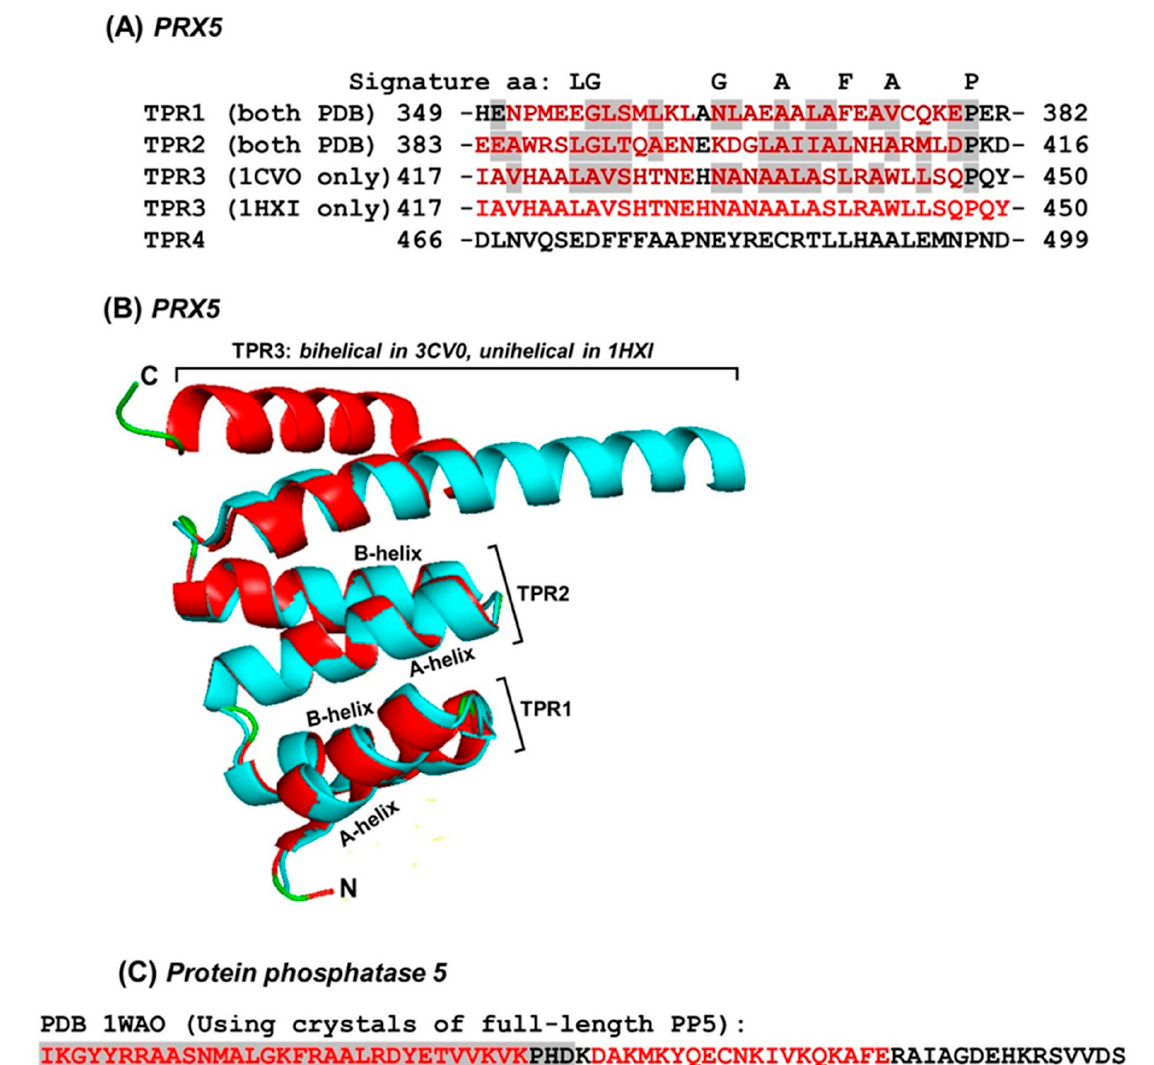
Figure 7. Single ‐ helix (unihelical) TPR units. ( A ) Only the first four TPR sequences of the seven ‐ TPR T. brucei PRX5 protein are aligned to mark the similar amino acids in TPR1, TPR2 and one TPR3 (shaded in grey, if present in two or more TPRs) while the general TPR signature residues are shown on top. The A ‐ helix and the B ‐ helix are colored red; note that the two helices of TPR3 are discernible in the structure of the full ‐ length protein that contain all seven TPRs (PDB structure 3CV0), but form one continuous long helix in the truncated protein (PDB structure 1HXI), indicated by the continuous red font color. ( B ) The first three TPR units of the 3CV0 (red color) and 1HXI (cyan color), corresponding to the sequences in Panel A, are superimposed using the merge function of PyMol. Note the bihelical structure of TPR3 in 3CV0 (red), and unihelical structure of the same TPR in 1HXI (cyan); TPR1 and TPR2 have retained the same bihelical structures in both constructs, as seen by complete superimposition. ( C ) Comparison of the helical regions, observed by X ‐ ray diffraction of crystals of the full ‐ length protein phosphatase 5 (PP5) and those of the 3 ‐ TPR domain only, devoid of the downstream sequence (PDB 1WAO and 1A17, respectively). Only the TPR3 (shaded grey) and the relevant portion of the downstream sequence are shown, as TPR1 and TPR2 structures were very similar in the two crystals. All helices—TPR and non ‐ TPR—are colored red. Note that the shorter fragment of PP5 has the canonical bihelical architecture, whereby the LGK loop region separates the A ‐ and B ‐ helices (not marked); the TPR is followed by a long 35 ‐ aa helix (KDA…VDS). In contrast, the full ‐ length protein (1WAO) shows a unihelical structure of the TPR, followed by a shorter helix, only 19 ‐ aa long (DAK..AFE).